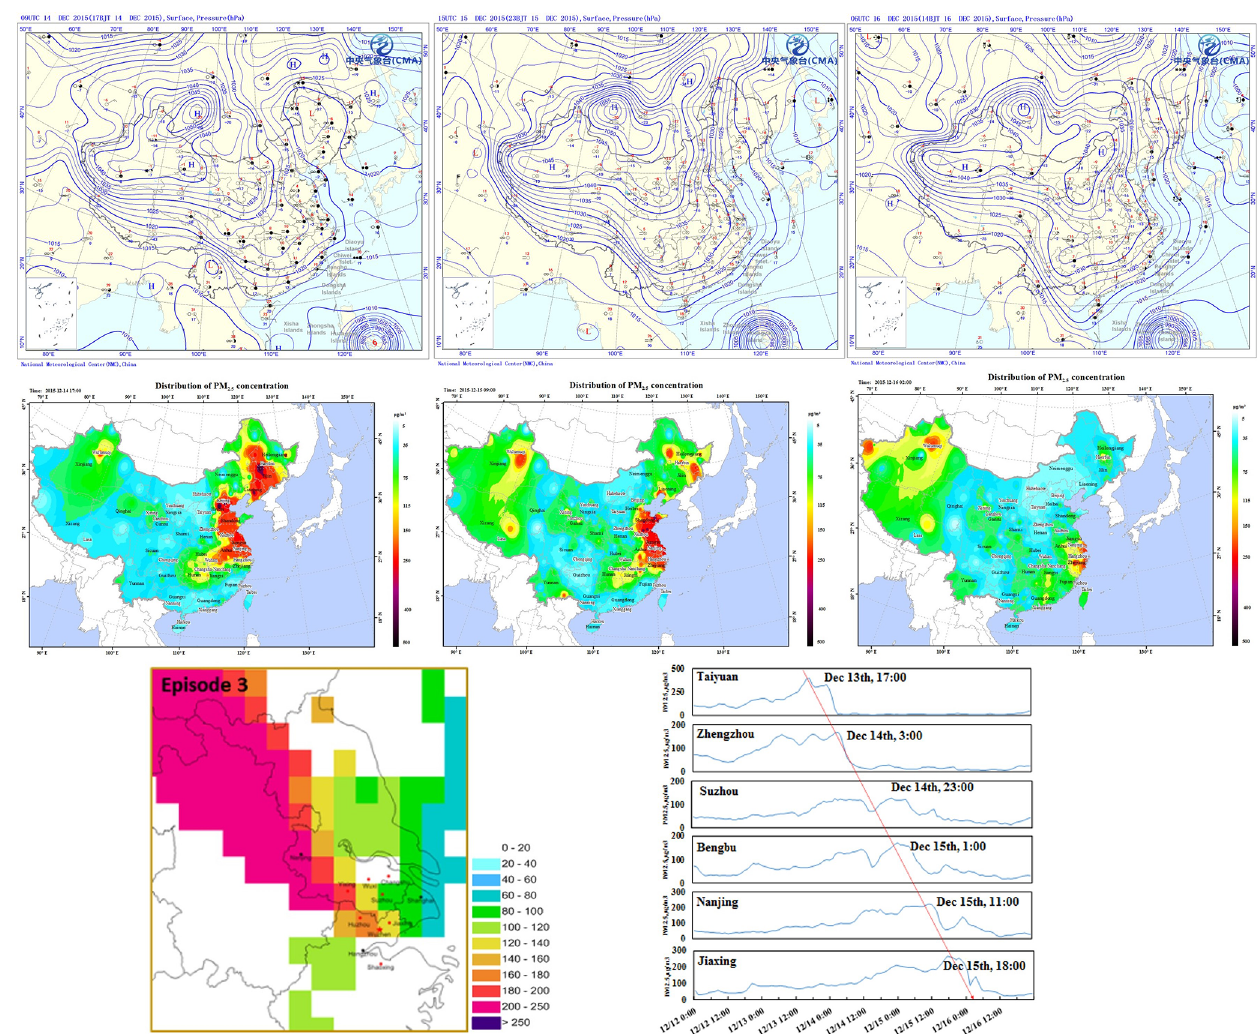
Figure 6. Analysis of (a) the large-scale weather patterns, (b) distribution of PM 2 . 5 concentrations, (c) potential regional sources, and (d) observed PM 2 . 5 time series for select sites during 14 to 16 December